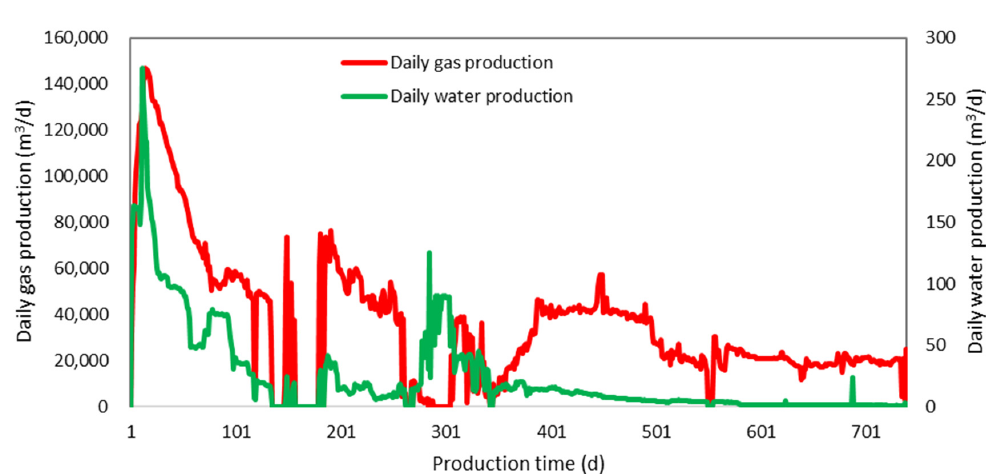
Figure 6. The production history of Well W5 (with the accurate prediction).